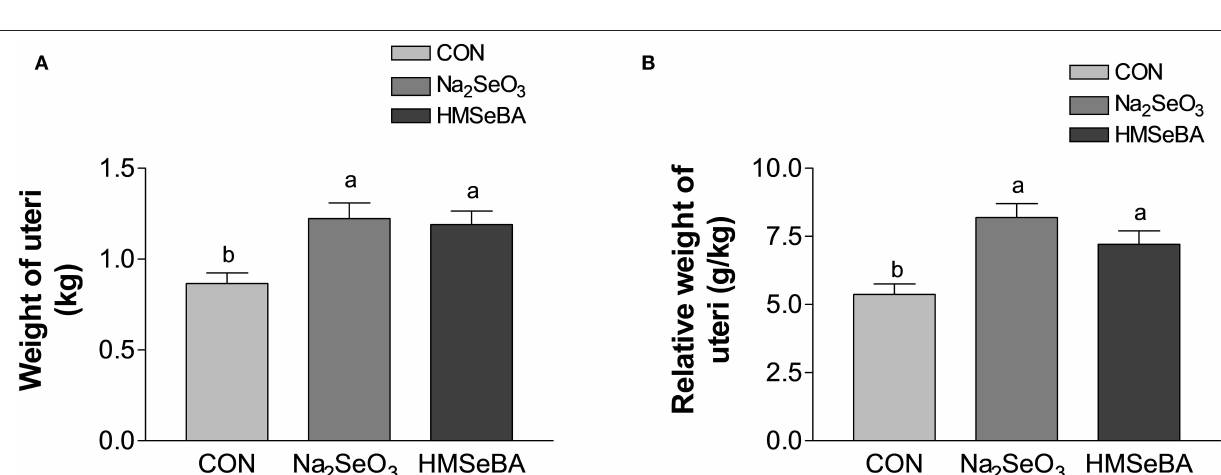
FIGURE 1 | Effects of dietary selenium supplementation on the selenium content in liver (A) , serum (B) and ovary (C) of gilts. Data are expressed as means values and standard error, n = 5. Mean values with different superscript letters were significantly different ( P < 0.05). CON, basal diet; Na 2 SeO 3 , 0.3mg Se/kg Na 2 SeO 3 ; HMSeBA, 0.3mg Se/kg HMSeBA.